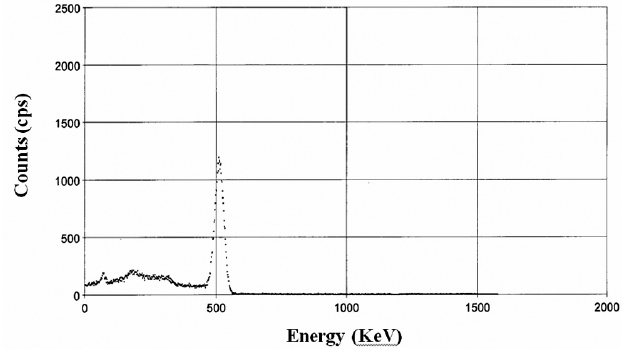
FIGURE 4 - Gamma spectrum obtained with a suitable detector to determine Na 18 F radionuclidic purity. Main peak can be observed at 0.511 MeV.